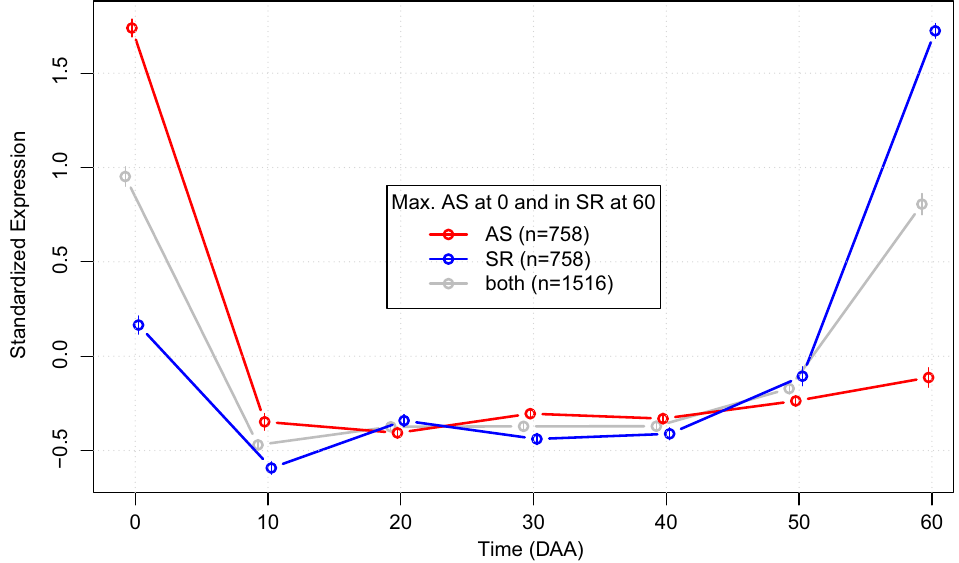
Figure 7. Average expression profiles for genes simultaneously having maximum expression at 0 DAA in accession “AS” but maximum expression at 60 DAA in accession “SR” (set “ ASm0SRm60 ”). Obtained with function “ SEPs.plot() ”; see Box 4 in Additional file 1.